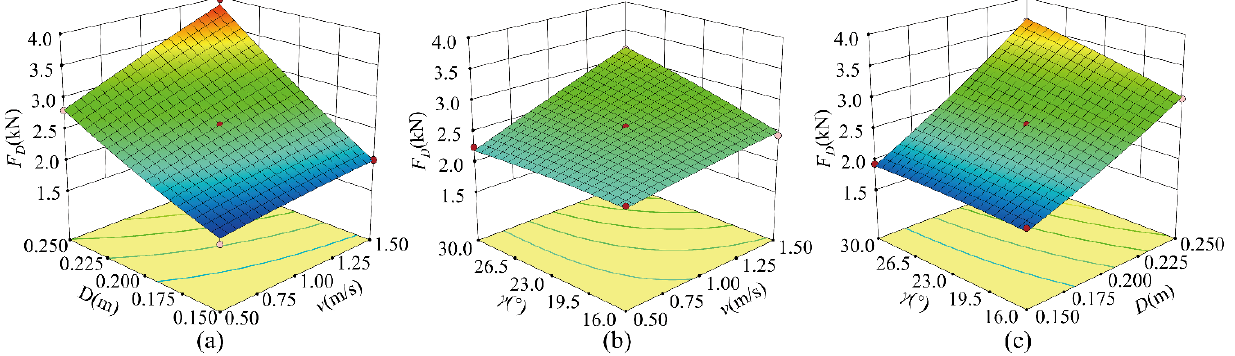
Figure 9. Response surfaces of the simulated draught force F D for DZ under the influence of different factors. ( a ) v and D , γ = 23 ◦ ; ( b ) v and γ , D = 0.20 m; ( c ) D and γ , v = 1